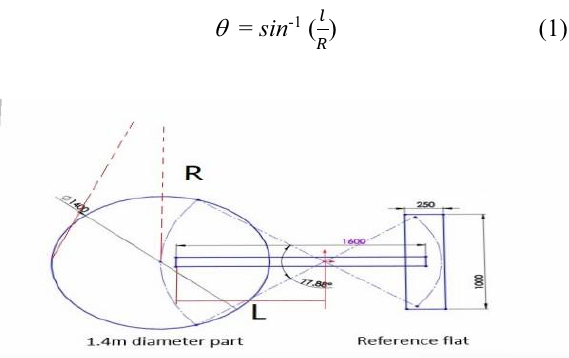
Fig. 1. Design of SAP for segment mirror development.